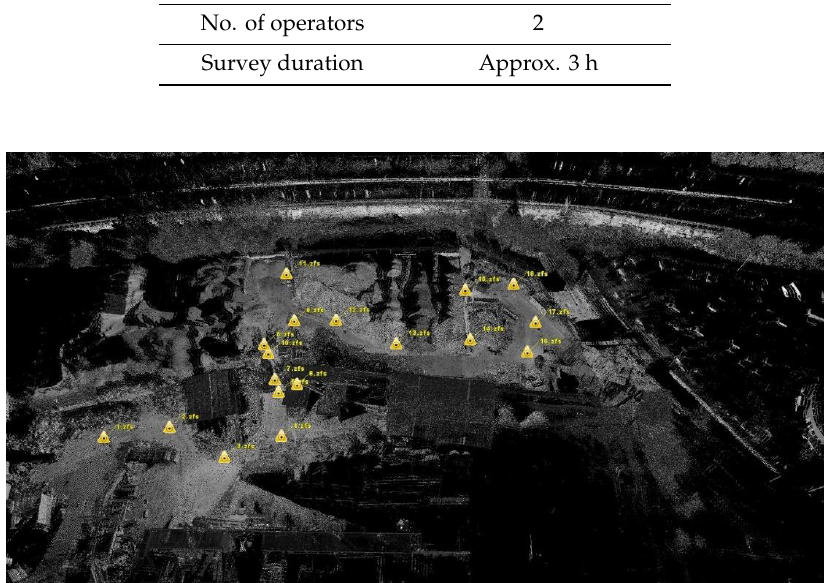
Figure 11. Localization of the laser scanner stations.